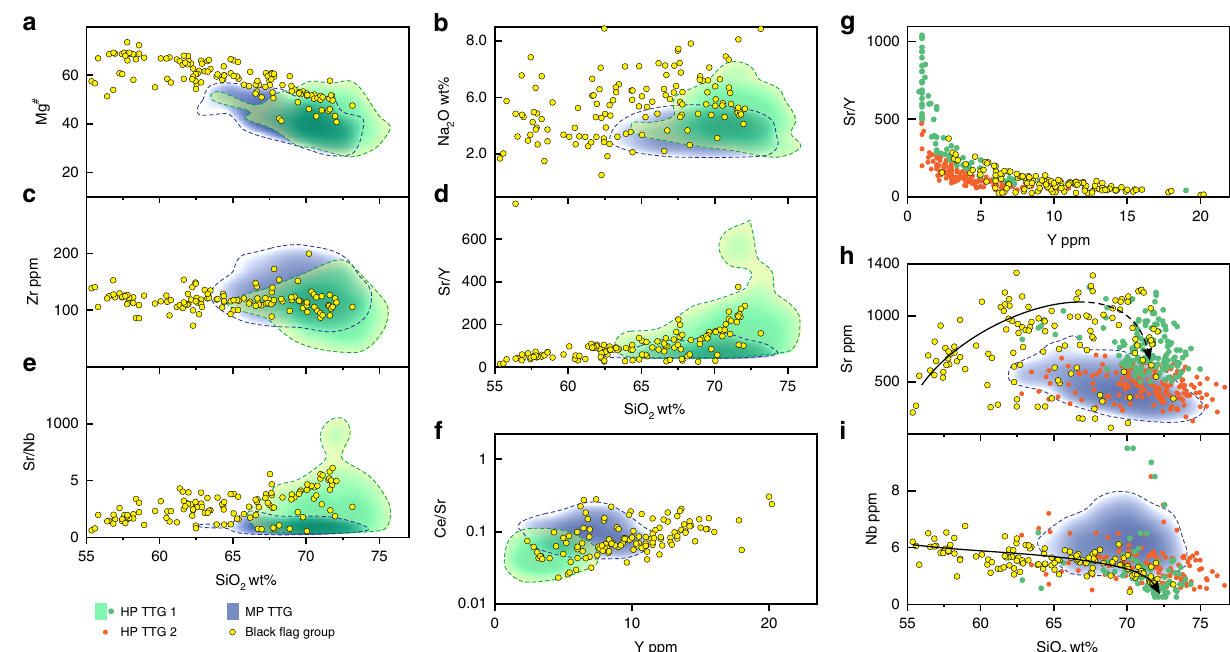
Fig. 6 Compositional comparisons between the Black Flag Group (BFG) and global high pressure TTG and medium pressure TTG. Variations in selected major and trace elements and trace element ratios (Mg # ( a ), Na 2 O ( b ), Zr ( c ), Sr/Y ( d ), Sr/Nb ( e )] with SiO 2 (calculated volatile free), Ce/Sr ( f ) and Sr/Y ( g ) with Y, and Sr ( h ) and Nb ( i ) with SiO 2 (calculated volatile free). Dashed lines in a – h outline kernel density plots comprising 90% of the data (see Methods). Trends lines in h and i are approximations of highest data density. High pressure (HP) TTG forms the evolved end member of the BFG array, critically also in terms of the compositional attribute used to distinguish medium-pressure (MP) and HP TTG. HP TTG can clearly be subdivided compositionally (6g) – one subdivision (HP TTG 1) being characterized by very high-Sr and typically low-Nb, is intersected by the BFG trend. The second subdivision (HP TTG 2), is distinct from silica-rich BFG but indistinguishable from MP TTG in terms of (for example) Sr and Nb (used to infer stability/ instability of plagioclase and rutile,